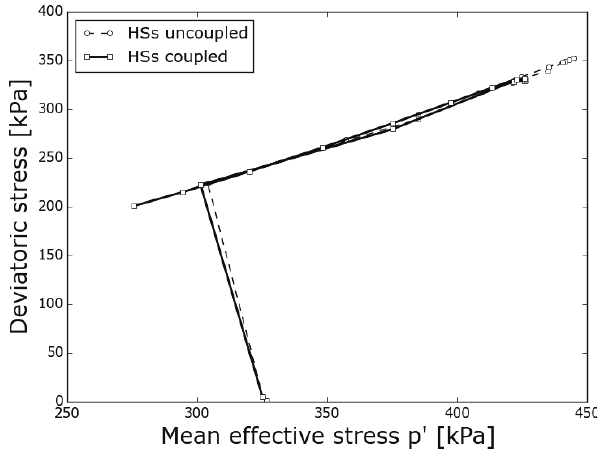
Fig. 9. Effective stress paths occurred in the element adjacent to the tunnel wall arch at 45 ° in the westbound